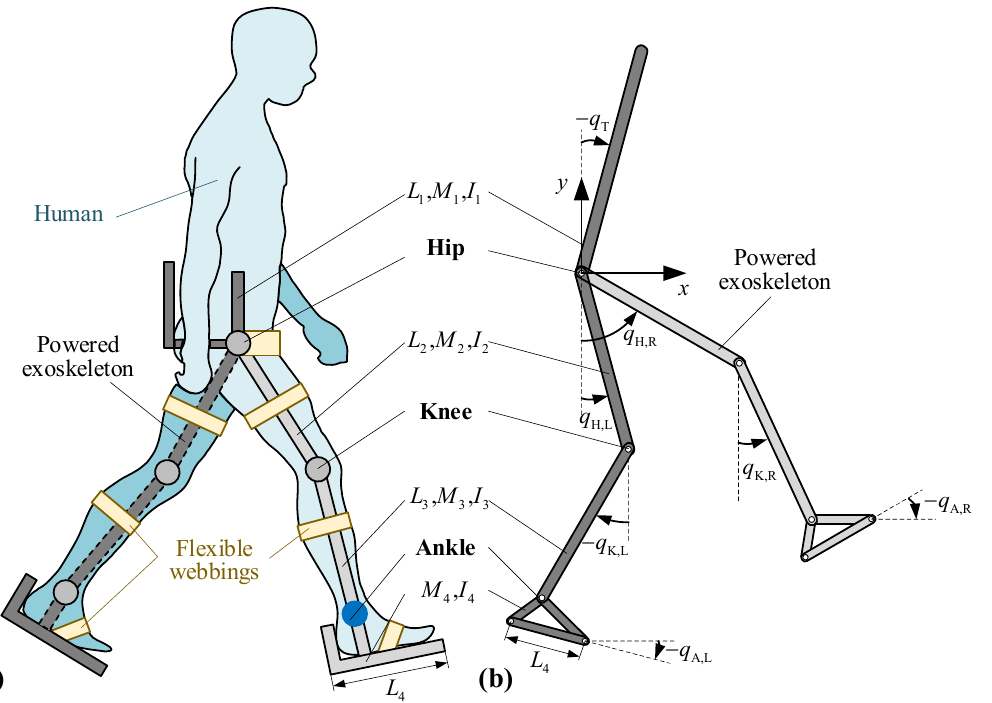
Figure 1. ( a ) Illustration of a human – exoskeleton system. ( b ) A dynamic model of the exoskeleton. For each part, the center of gravity is assumed to be located at the geometric center. For the trunk, the length, mass, and the moment of inertia about the center of gravity are denoted by L B , M B , and I B , respectively. For each thigh, shank, and foot of the exoskeleton, we denote their lengths by L T , L S , and L F , respectively, their masses by M T , M S , and M F , respectively, and the moments of inertia with respect to the corresponding centers of gravity by I T , I S , and I F , respectively. The angles of the trunk ( q B ), the thighs ( q TL and q TR ), and the shanks ( SL q and SR q ) are measured from the vertical axis, and the angles of the feet ( FL q and FR q ) are measured from the horizontal axis, with the counterclockwise direction defined as positive. In the above parameters, the subscripts ‘B’, ‘T’, ‘S’, and ‘F’ denote the trunk, the thighs, the shanks, and the feet, respectively, and the subscripts ‘L’ and ‘R’ denote the left and the right side, respectively. In this research, without the loss of generality, ( TL q , TR q ), ( SL q , SR q ), and ( FL q , FR q ) are also used to denote the angles of the hip, the knee, and the ankle joints of the exoskeleton, respectively. Note that the studied 9-DOF exoskeleton possesses seven joints to be controlled, which exceeds the technological level of the current powered lower extremity exoskeleton prototypes. The reason for studying such a hypothetical example is to demonstrate the capability of the proposed controller in tackling high-dimensional systems in a real-time manner, which will be discussed in Section 3. 2.2. Dynamic Modeling The controller to be constructed in this research does not depend on a prior dynamic model of the human – exoskeleton system. The purpose of modeling in this subsection is to provide a platform for the dynamic simulation experiments, based on which the effectiveness of the proposed controller can be examined, and the unique merits can be uncovered by comparing with the conventional PID control. Based on such purposes, the